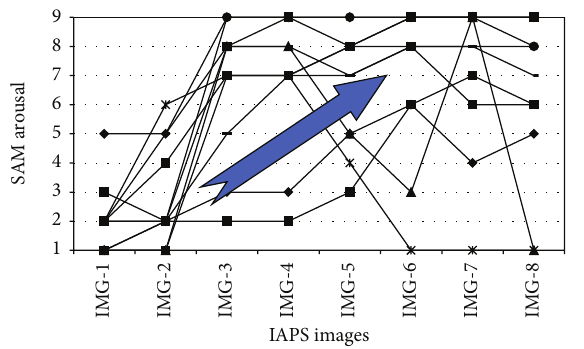
Figure 3: Arousal assigned by participants to IAPS selected images.